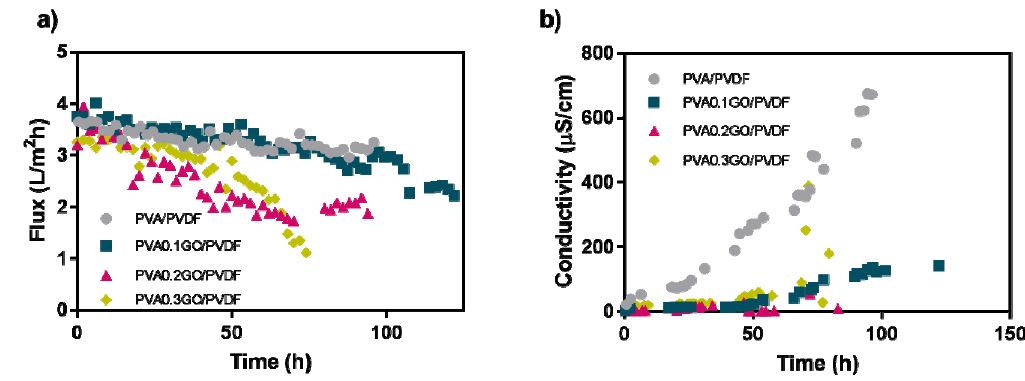
Figure 9. ( a ) Flux and ( b ) permeate conductivity profiles of the composite membrane using a feed solution of 100 g/L NaCl at 65 °C.